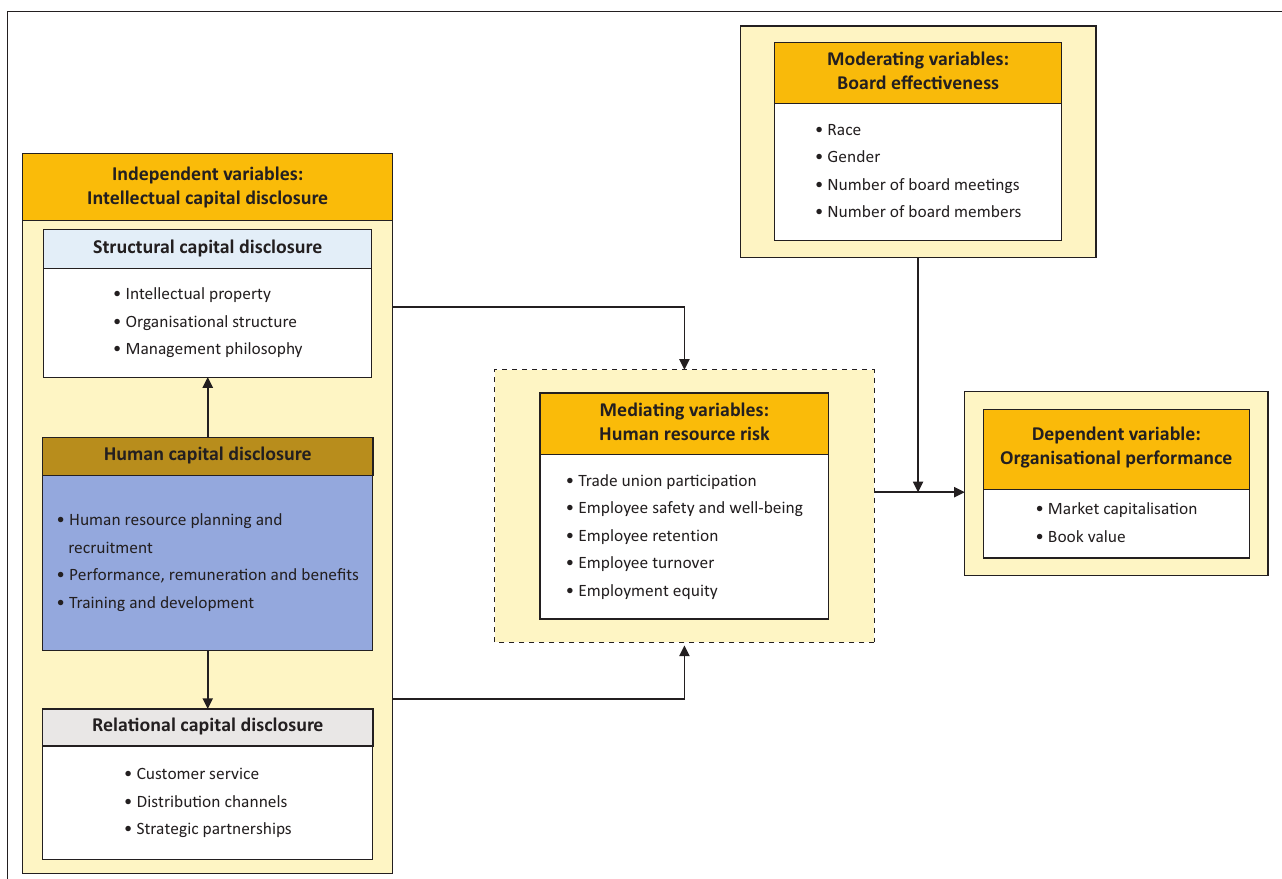
FIGURE 1: A predictive model of human capital disclosure as a dimension of intellectual